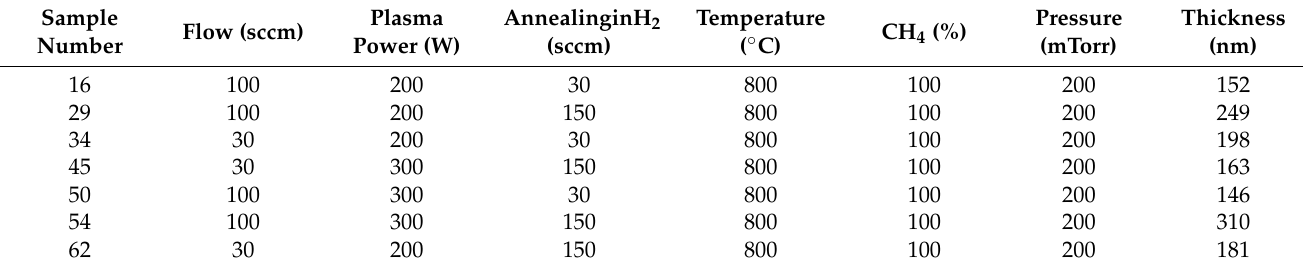
Table 1. Process Parameters of PECVD Deposition of Vertical Graphene at which it